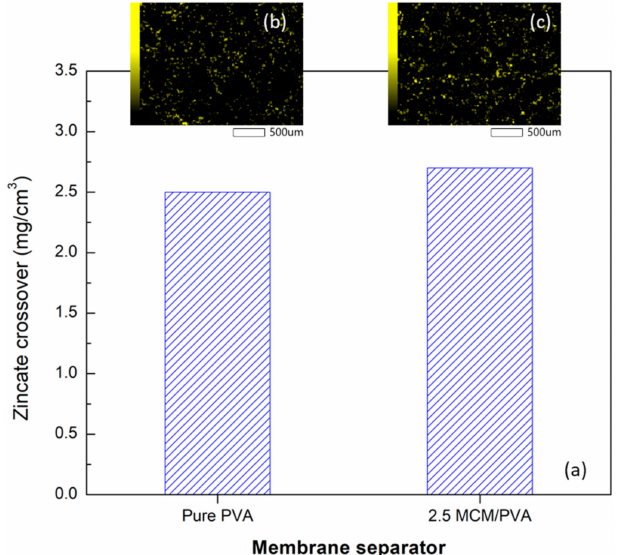
Figure 6. ( a ) Zincate crossover of the PVA membrane without MCM-41 and 2.5 wt.% MCM / PVA composite membrane after 150 h of use ( b ) and ( c ) EDS element mapping of Zn on the air cathode in contact with the PVA membrane and the composite membrane,